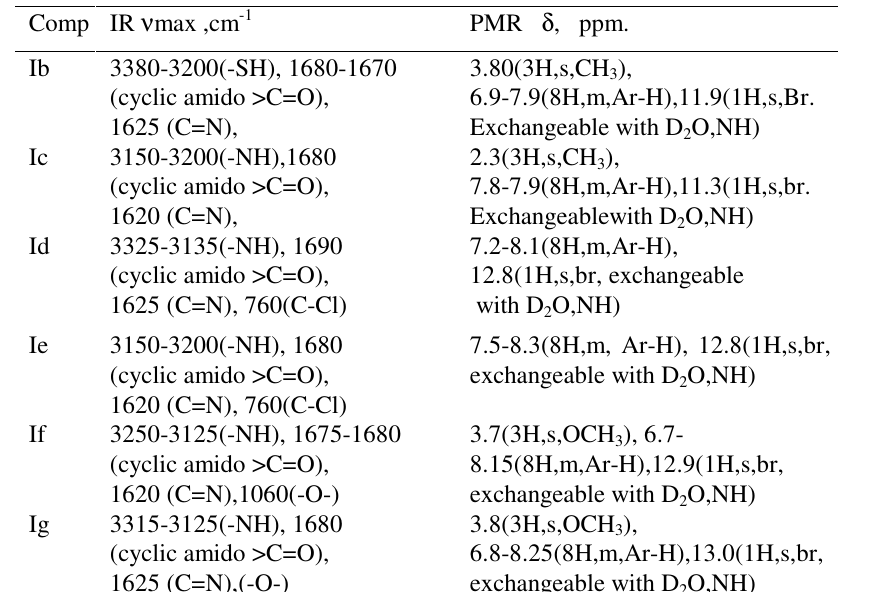
Table 2 .Spectral